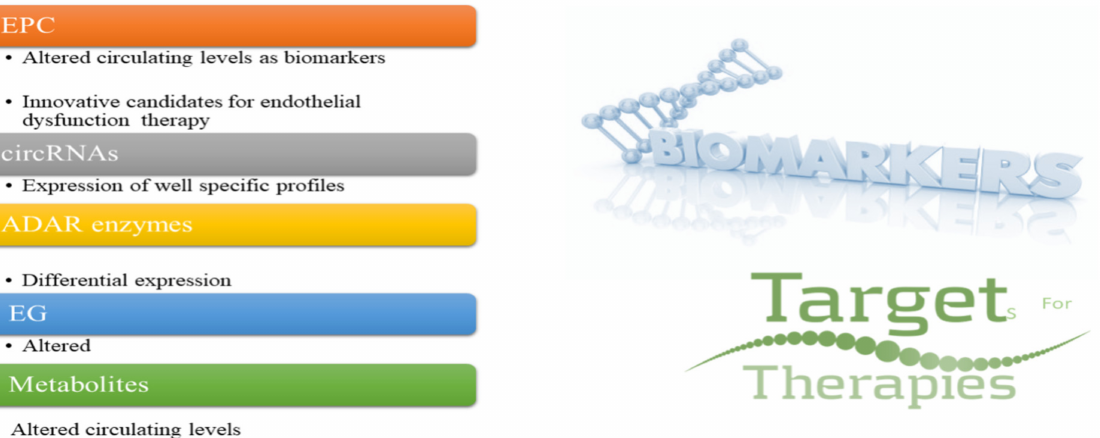
Figure 7. Innovative non-invasive biomarkers and therapeutic